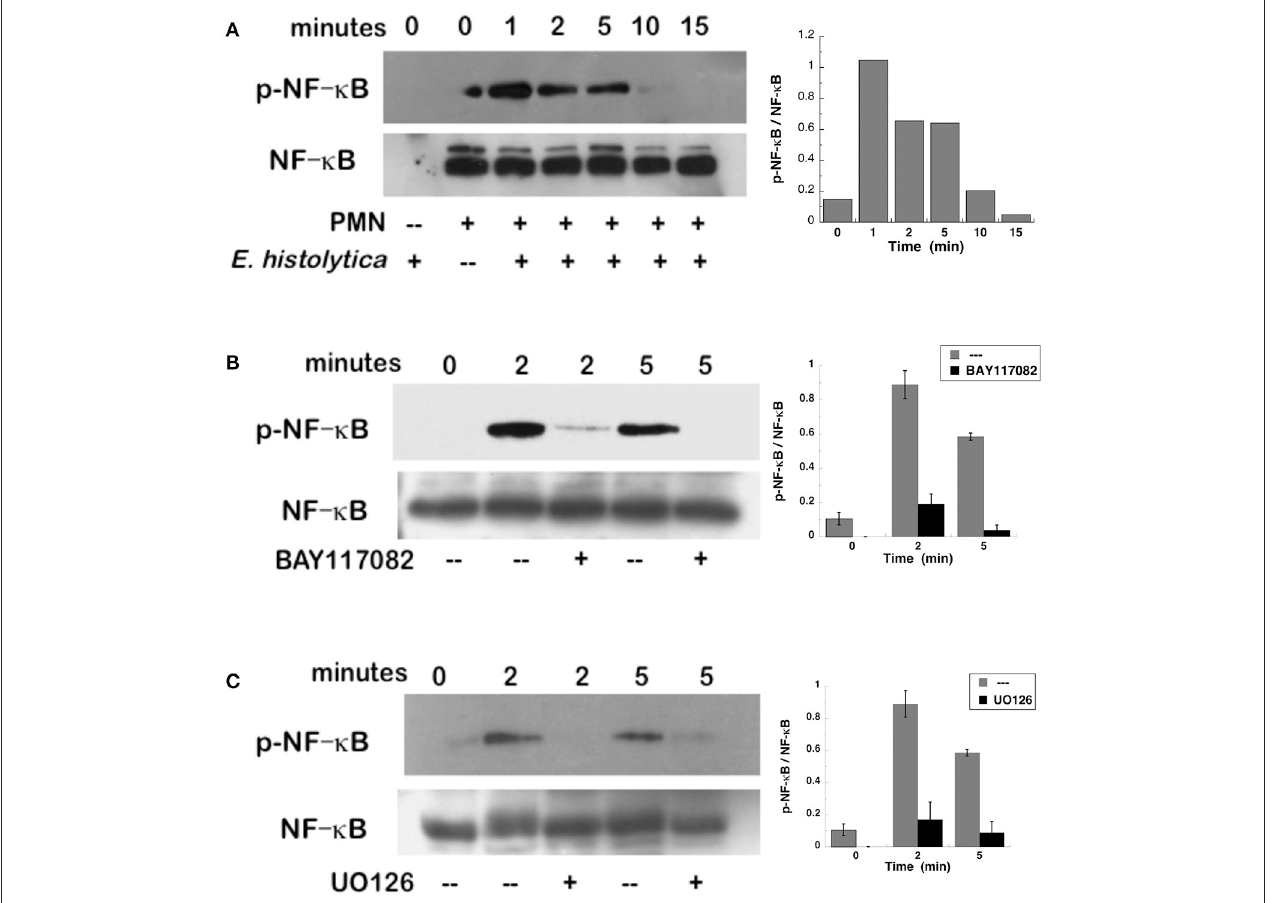
FIGURE 12 | Entamoeba histolytica induce activation of NF- κ B. Human neutrophils were stimulated with E. histolytica trophozoites for various periods of time, and then cell lysates were prepared. Neutrophils were (A) left untreated, or previously treated with (B) the NF- κ B inhibitor BAY117082 (5 µ M), or with (C) the MEK inhibitor UO126 (75 µ M). Proteins were resolved by SDS-PAGE, and then Western blotted for phosphorylated-NF- κ B (p-NF- κ B) (upper panel) or for total NF- κ B (lower panels) to show equal loading of proteins. Plots on the right show densitometric analysis for the ratio of p-NF- κ B/NF- κ B. Data are mean ± SEM of three